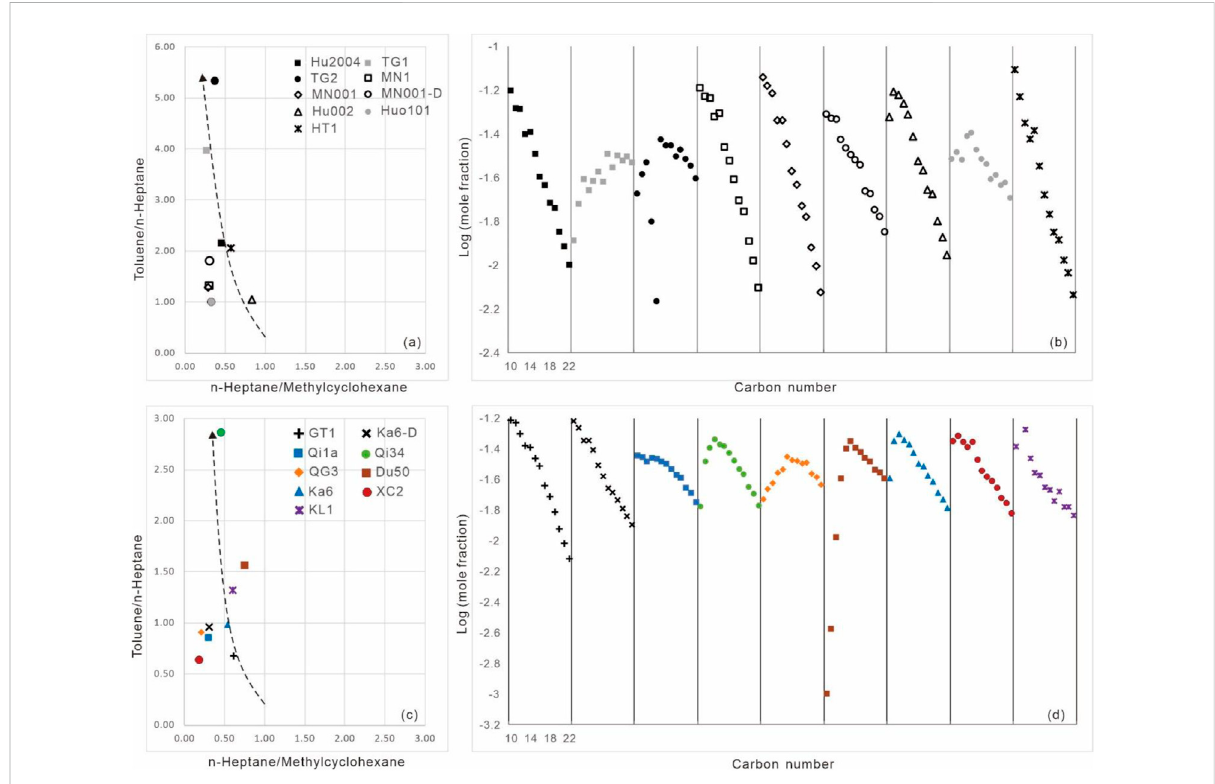
FIGURE 8 Crossplots of (A) the toluene/ n -heptane versus n -heptane/methylcyclohexane and (B) carbon number versus the log of mole fraction for the C 10 – C 22 n -alkanes for Group I oils; (C) the toluene/ n -heptane versus n -heptane/methylcyclohexane and (D) carbon number versus the log of mole fraction for the C 10 – C 22 n -alkanes for Group II – V